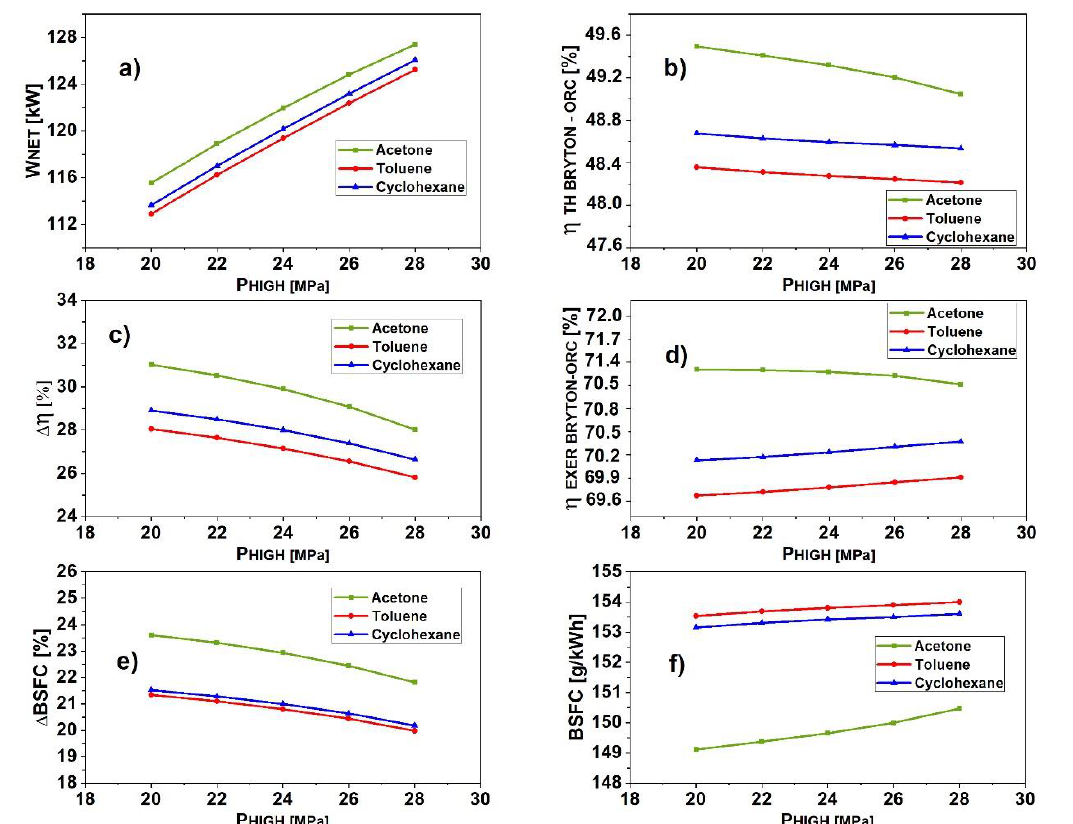
Figure 6. System performance parameters with respect to P HIGH , ( a ) net power; ( b ) thermal efficiency Brayton-ORC; ( c ) absolute increase in thermal efficiency; ( d ) exergy efficiency Brayton-ORC; ( e ) brake-specific fuel consumption; ( f ) absolute decrease in brake-specific fuel consumption.